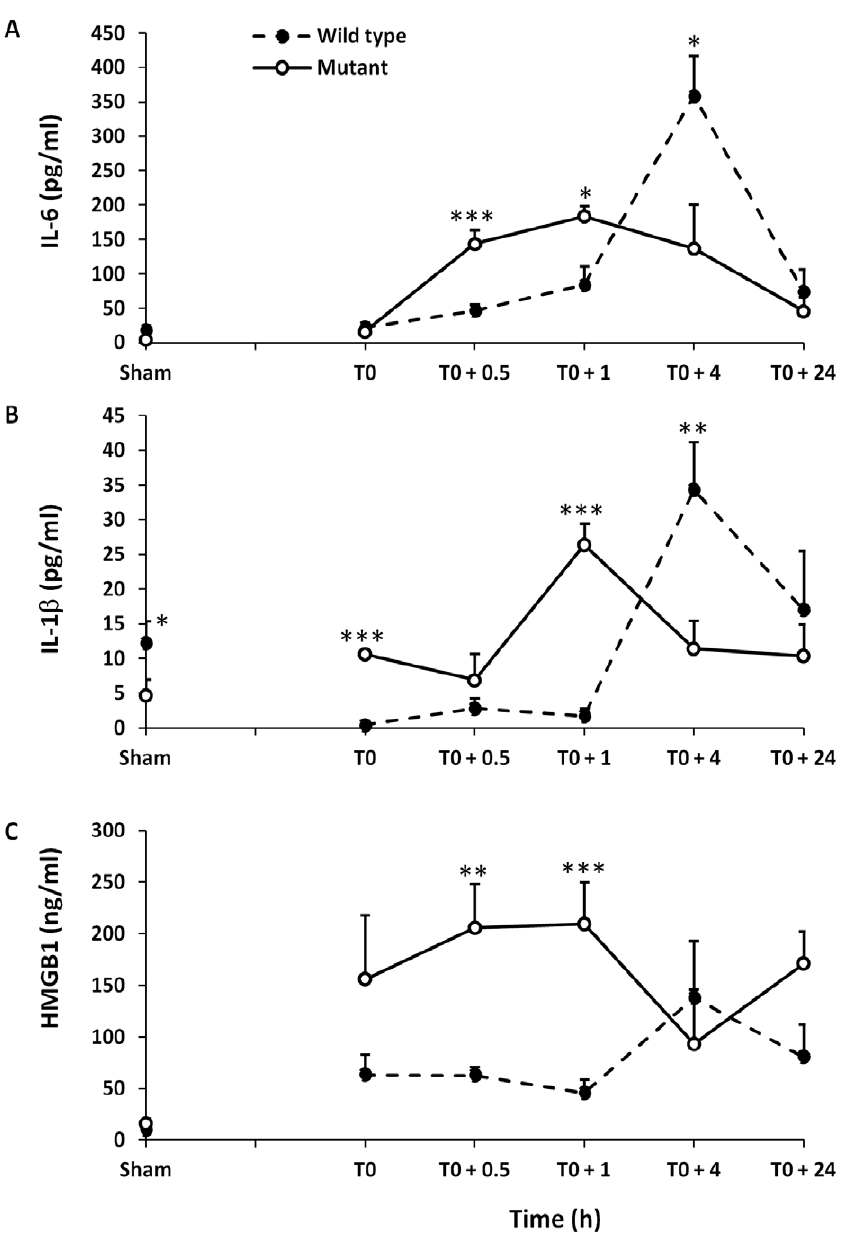
Figure 4. Comparison of plasma IL-6, IL-1 b and HMGB1 levels in mutant and wild type mice. ( A ) Plasma levels (mean 6 SD) of IL-6, ( B ) IL- 1 b and ( C ) HMGB1 are compared with mutant and wild type mice at the onset of heatstroke (T0) and at T0 + 0.5, + 1, + 4 and + 24 hours post heatstroke. Plasma levels from sham-heated animals’ represent baseline. *P , 0.05; **P , 0.001; and ***P , 0.0001 statistical significance at given time points between the two groups tested by the generalized estimating equations